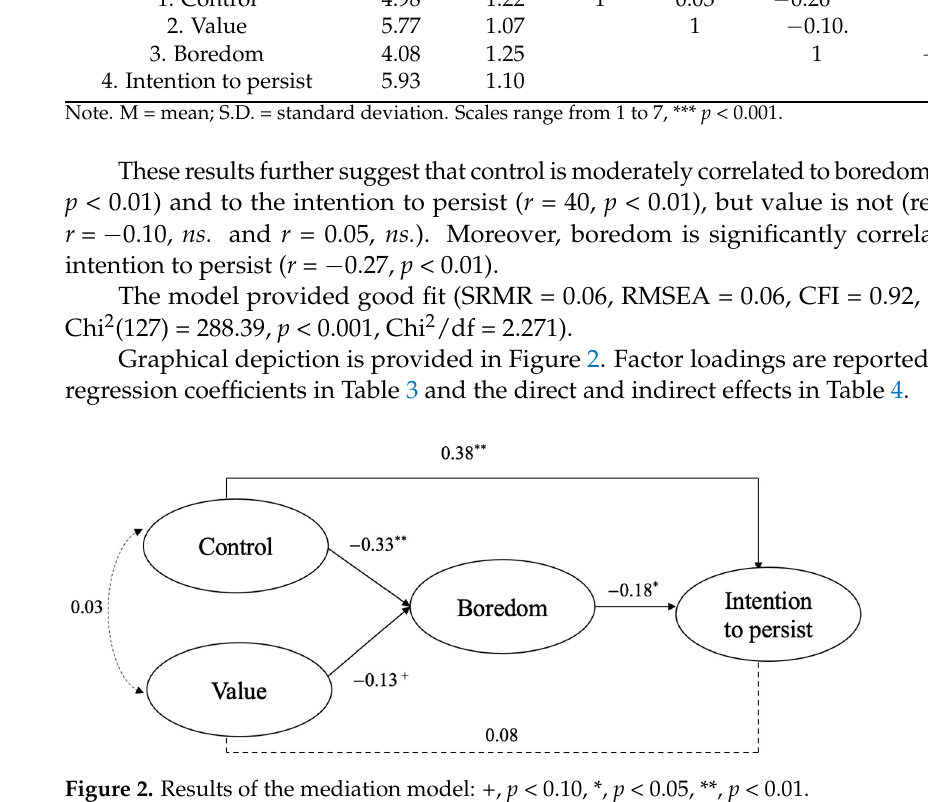
Table 3. Regression coefficients between factors.